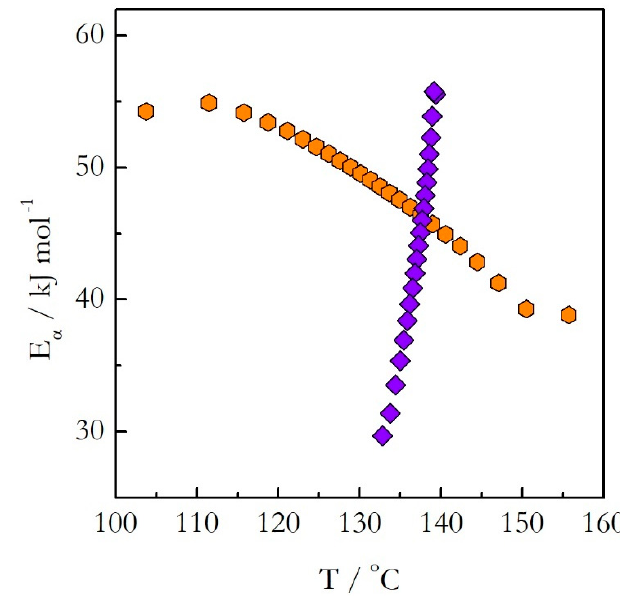
Figure 6. The isoconversional activation energy as a function of temperature for the stoichiometric polymerization of DGEBA and m-PDA evaluated on heating (orange hexagons) and cooling (violet diamonds) [22,23]. Adapted from Ref. [22] with permission from Wiley.